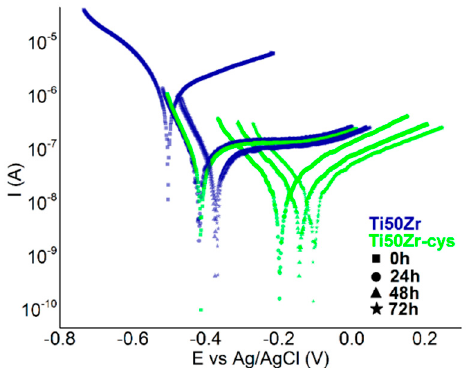
Figure 3. Tafel plots in time for Ti50Zr substrate and coated samples. Table 1. The electrochemical stability data obtained from Tafel plots.